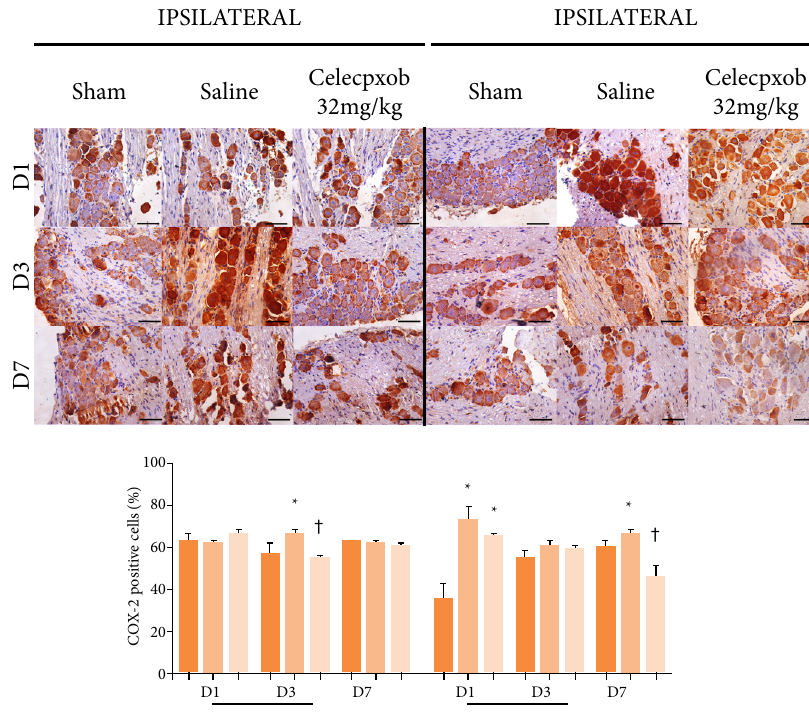
Figure 3 - COX-2 immunostaining of cell bodies of trigeminal neurons after one, three, and seven days of exposure to an experimental model of dental occlusal interference in rats treated with a selective COX-2 inhibitor (celecoxib, Eurofarma ® ). One-way ANOVA/Bonferroni (mean ± standard error). Immunohistochemistry, 400×, horizontal line = 50 μ